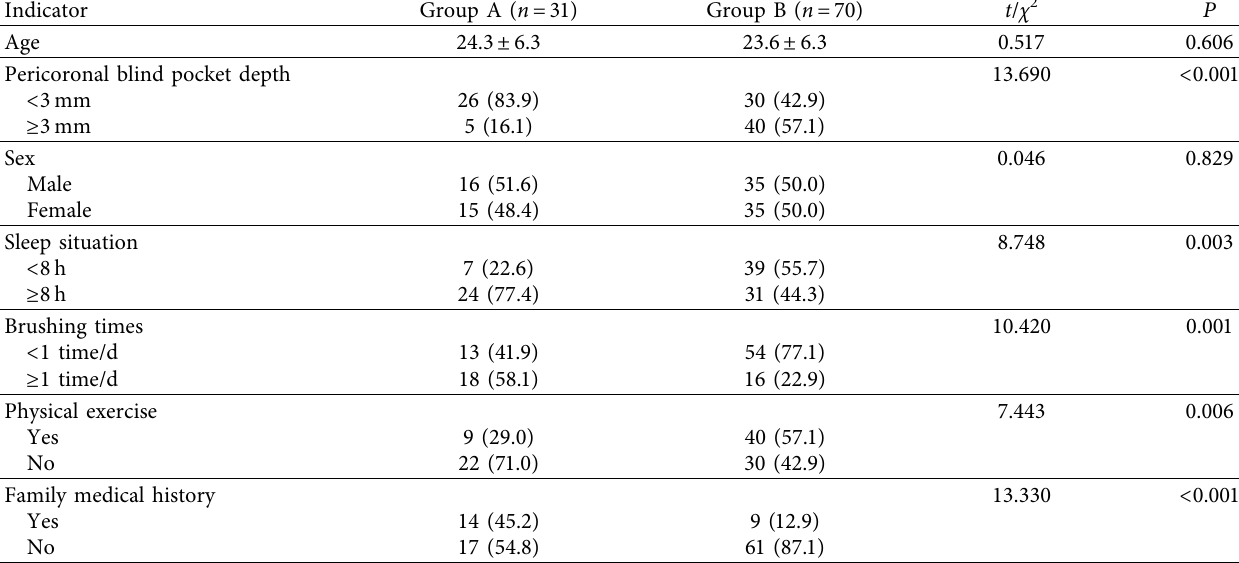
Table 1: Incidence of pericoronitis in patients with complex impacted mandibular teeth.